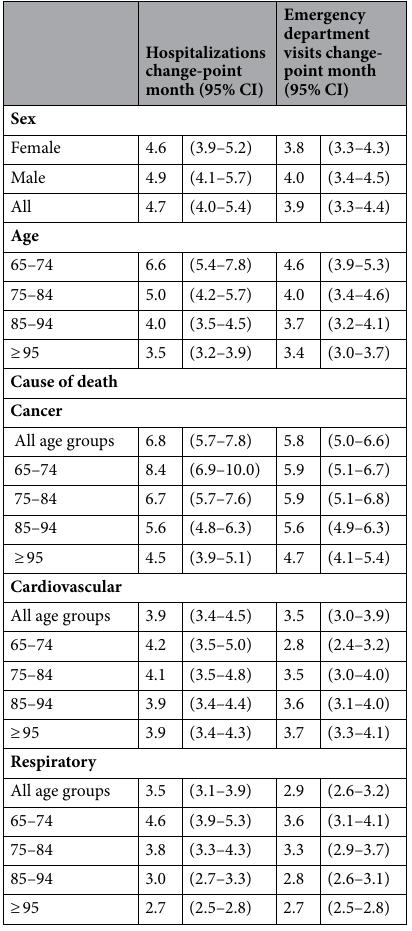
Table 2. Change-point analysis indicating the month before death when the proportion of individuals who were hospitalized and had accessed the emergency department exponentially